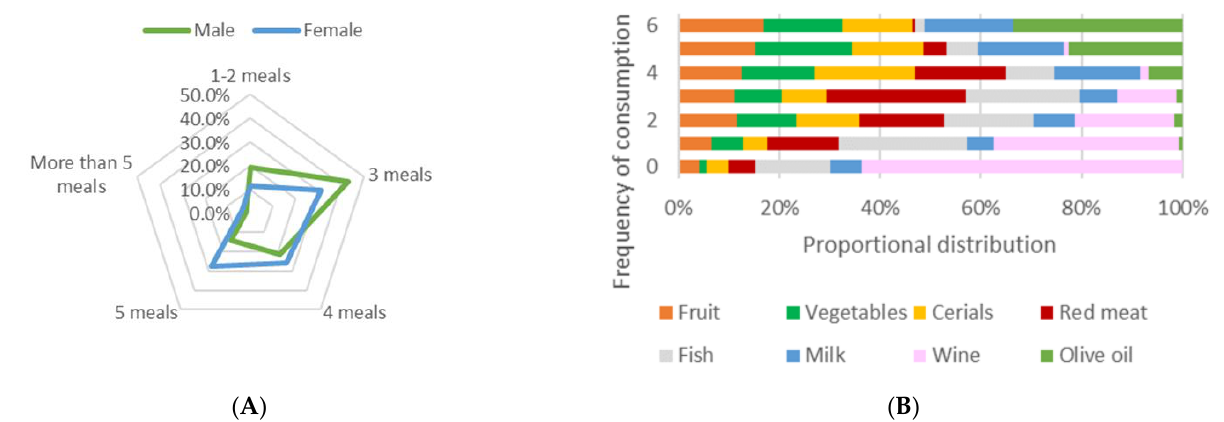
Figure 4. Consumed meals per day, food choices and % frequency of consumption. ( A ) Overall consumed meals per day: responses % for male and female participants, ( B ) overall food choices and % frequency of consumption for all responders (0 = never, 1 = 1 – 2 times per month, 2 = 2 – 3 times per month, 3 = 1 – 2 times per week, 4 = 3 – 4 times per week, 5 = 4 – 5 times per week, and 6 = daily). Table 4. Dietary habits of positive responders in the use of MAPs. Common Use of MAPs Therapeutic Use of